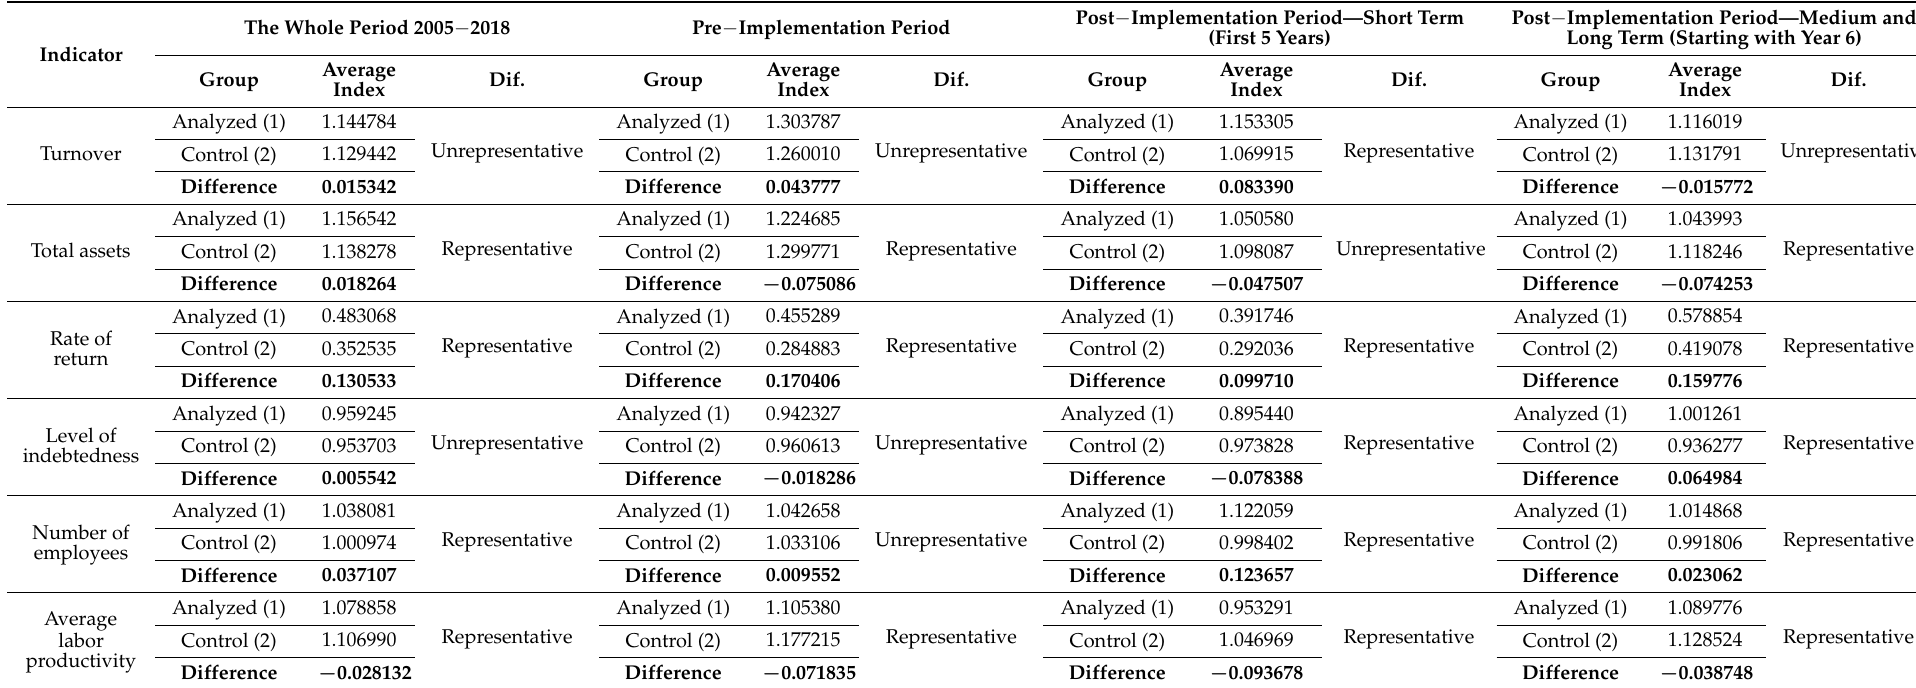
Table 1. Centralization of media comparison